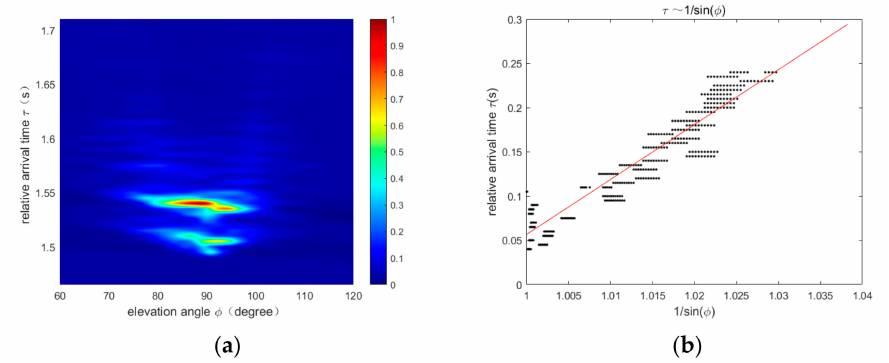
Figure 3. ( a ) The sound-intensity map in beam-time domain generated by performing STCBF on measured signal; ( b ) t ∼ 1/ sin ( φ ) relationship obtained by SOF.